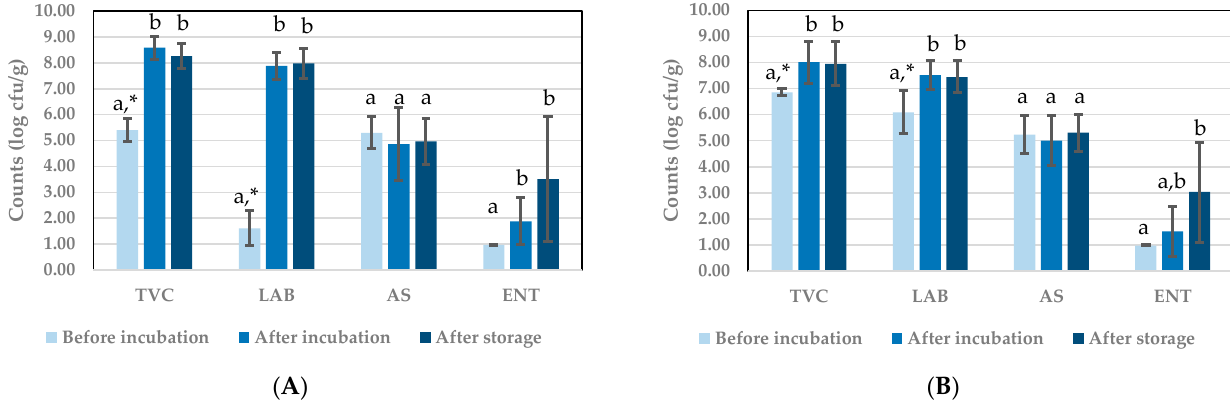
Figure 3. Microbial counts during experiments to investigate the potential of starter Bactoferm® F-LC: ( A ) replicates incubated without starter (control); ( B ) replicates incubated with starter. Results are the mean of three replicates ( n = 3). TVC: total viable counts; LAB: lactic acid bacteria counts; AS: aerobic endospore counts; ENT: Enterobacteriaceae counts. a,b Means per microbial count with the same superscript do not differ significantly. * Corresponding means indicated with asterisks are significantly different.